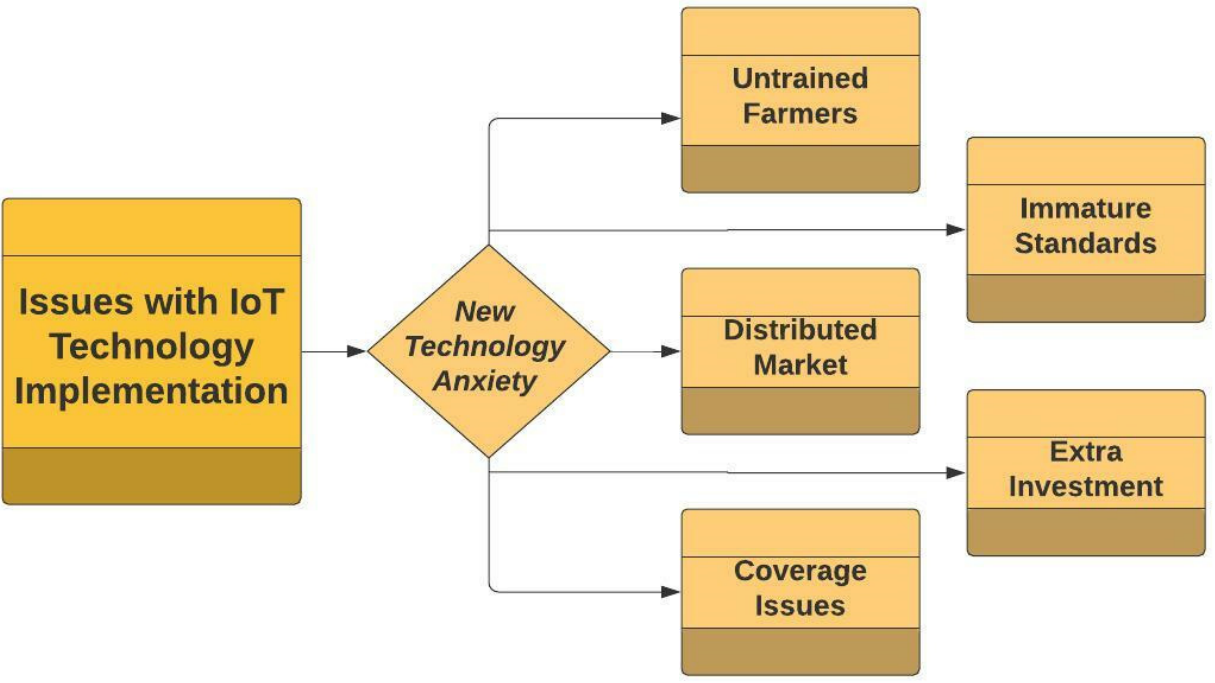
Figure 1. Major issues in IoT implementation in Agriculture.